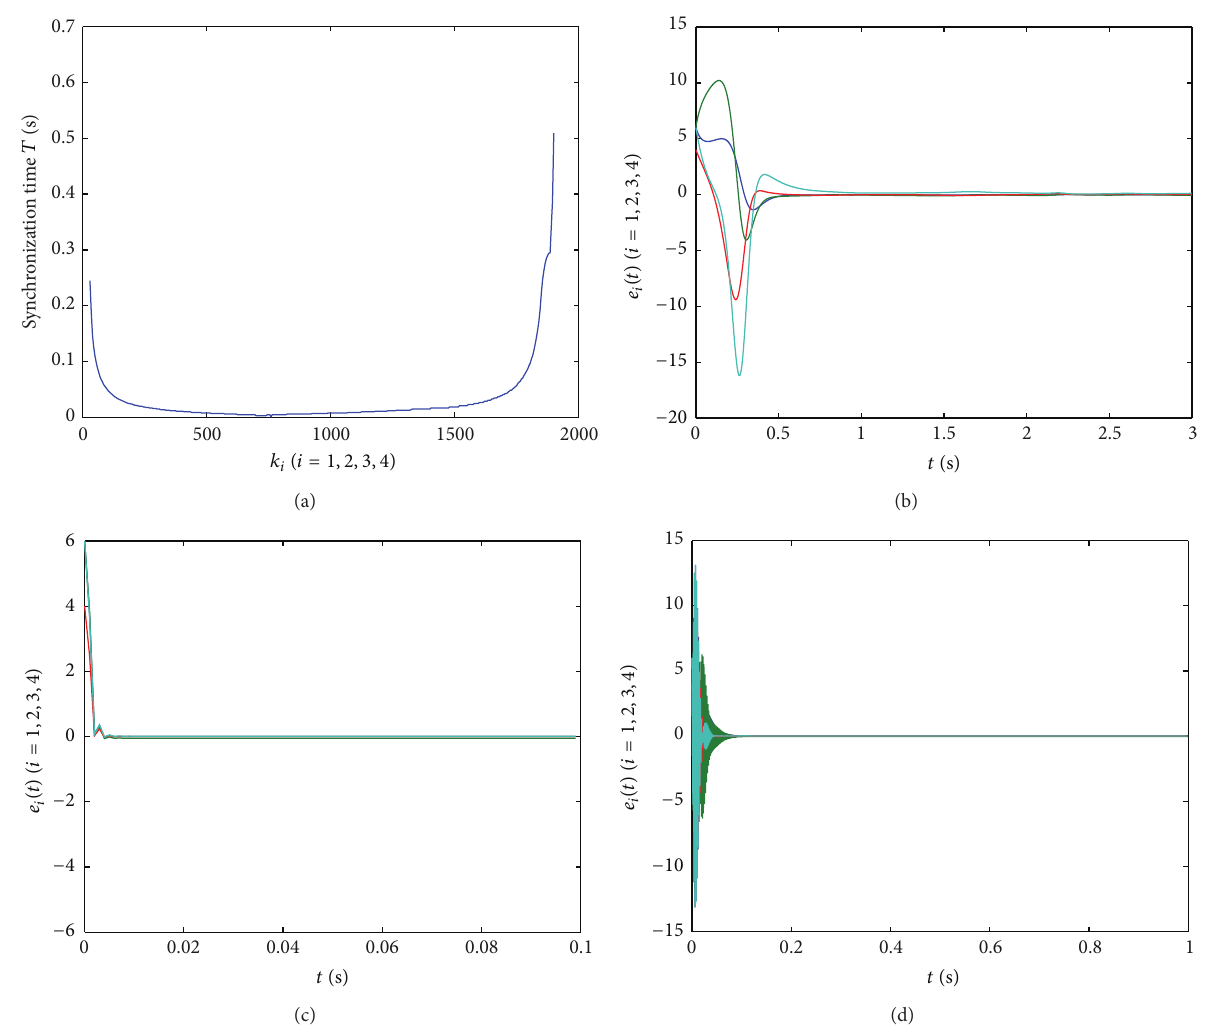
Figure 6: The waveform of synchronization time with the control parameters 𝑘 𝑖 (𝑖 = 1,2,3,4) (a) and time waveforms of synchronization errors between two hyperchaotic Lorenz systems with parameter 𝑘 𝑖 = 10 (b), 750(c), 1800 (d) (𝑖 = 1,2,3,4) , respectively.